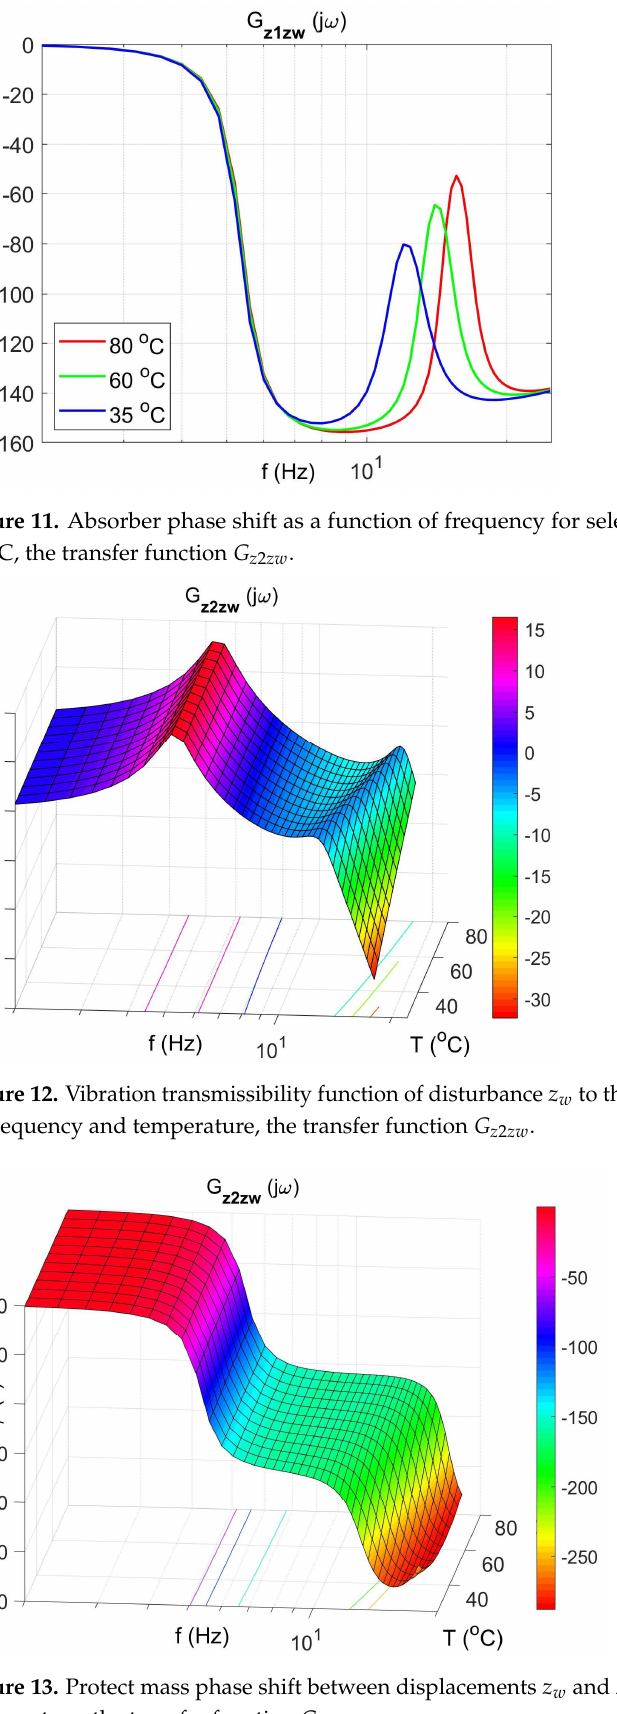
Figure 10. Vibration transmissibility functions of disturbance (cid:1878) (cid:3050) to the protected mass (cid:1865) (cid:2869) as a function of frequency for selected temperatures 25 °C, 60 °C, 80 °C, the transfer function (cid:1833) (cid:3053)(cid:2869)(cid:3053)(cid:3050) .